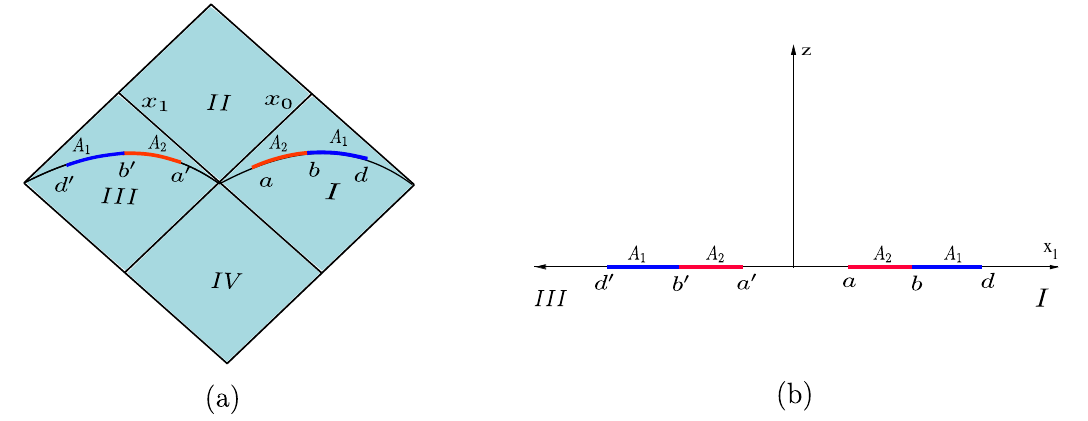
Figure 8 . (a) Two adjacent intervals A 1 (blue) and A 2 (red) in the Rindler wedges I and III respectively of the Minkowski diamond. (b) These two intervals are projected on the x 1 - z plane of the Poincar´e